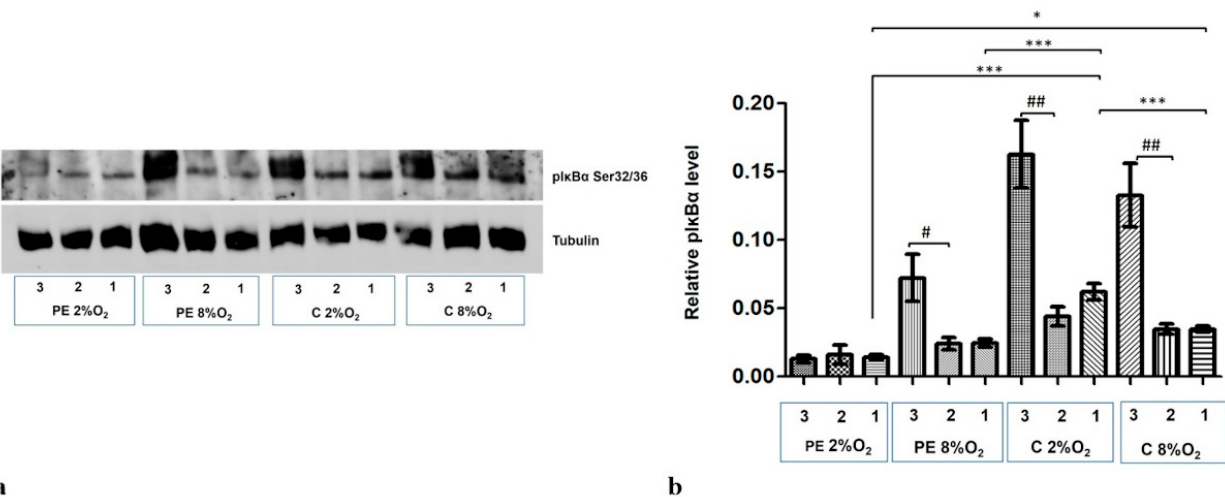
Figure 5. Western blot results for pI κ B α Ser32/36 in the cytoplasmic fraction after MG-132 stimulation. The cells were cultured for 96 h in hypoxic or normoxic conditions with medium containing 1% serum from preeclamptic or normotensive women. For the last three hours, the culture medium was supplemented with the following factors: MG-132 (3), DMSO as the MG-132 vehicle (2) or none, i.e., cells incubated only with medium containing maternal serum without MG-132 or DMSO addition (1). ( a ) The Western blot membrane with pI κ B α and Tubulin as a loading control ( b ) the analysis of Western blot results. Values are presented as mean ± SEM; ( n = 3 experiments). The differences in pI κ B α level between cells with DMSO and MG-132 were analyzed by Student’s t -test, # p < 0.05, ## p < 0.01. The difference in pIkB α level for cells not stimulated by DMSO or MG-132 but grown in hypoxia/normoxia and control/preeclamptic serum were analysed by ANOVA with the Bonferroni post hoc test; * p < 0.05, *** p < 0.001.